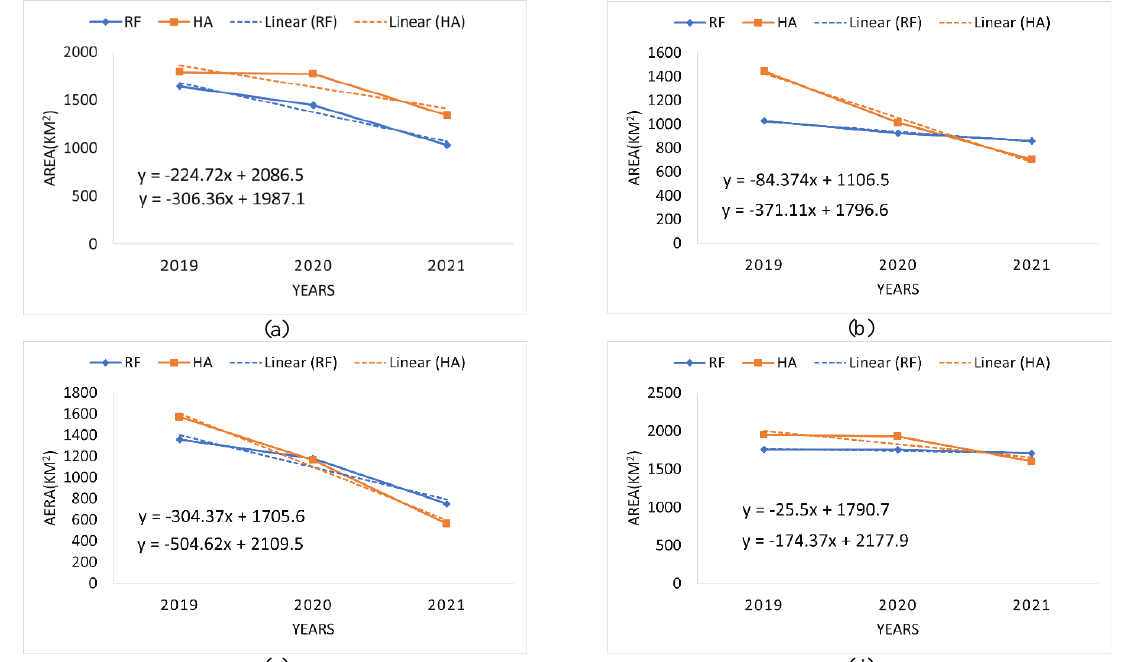
Figure 6. Variation trend of water area in (a) Spring, (b) Summer, (c) Autumn, and (d) Winter during 2019-2021 for HA and RF Models.